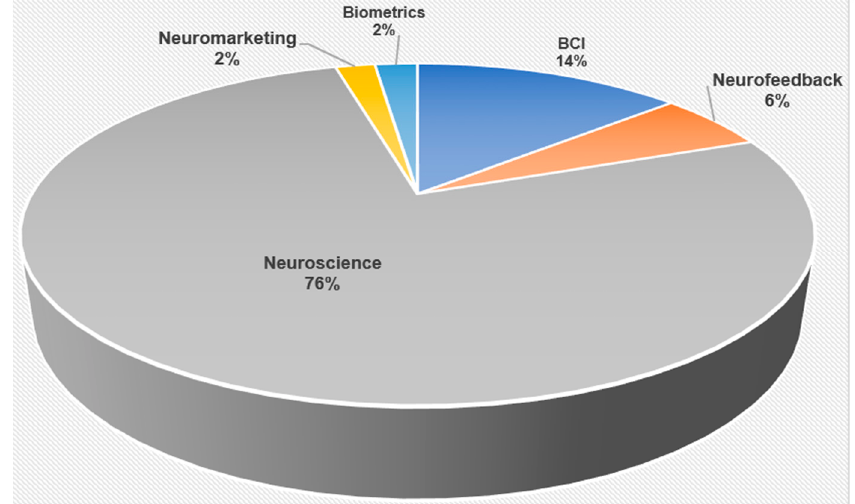
Figure 4. Percentage of each topic found through internet keyword search.